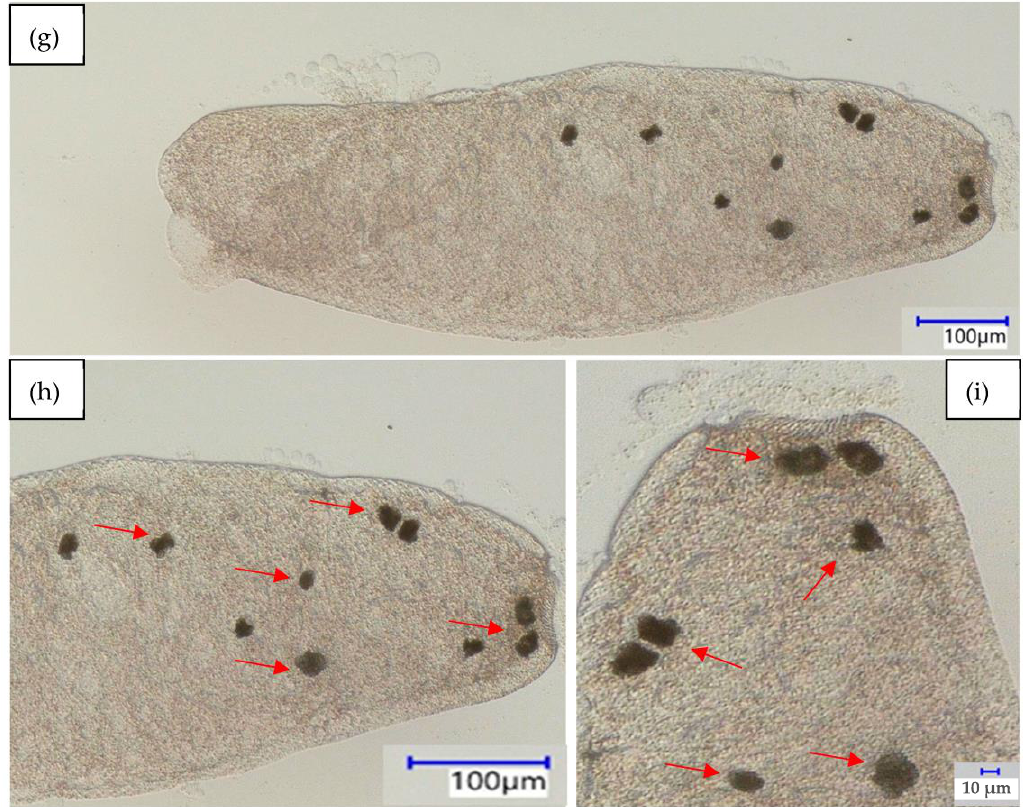
Figure 6. Food vacuoles formed by Spirostomum ambiguum . ( a – c ) baker’s, yeast; ( d , e ), and ( f ) phenolic resin microparticles; ( g – i ) polystyrene microparticles. → enlargement and mark food vacuoles ( b , c ) baker’s yeast; ( e , f ) phenolic resin microparticles; and ( h , i ) polystyrene microparticles.